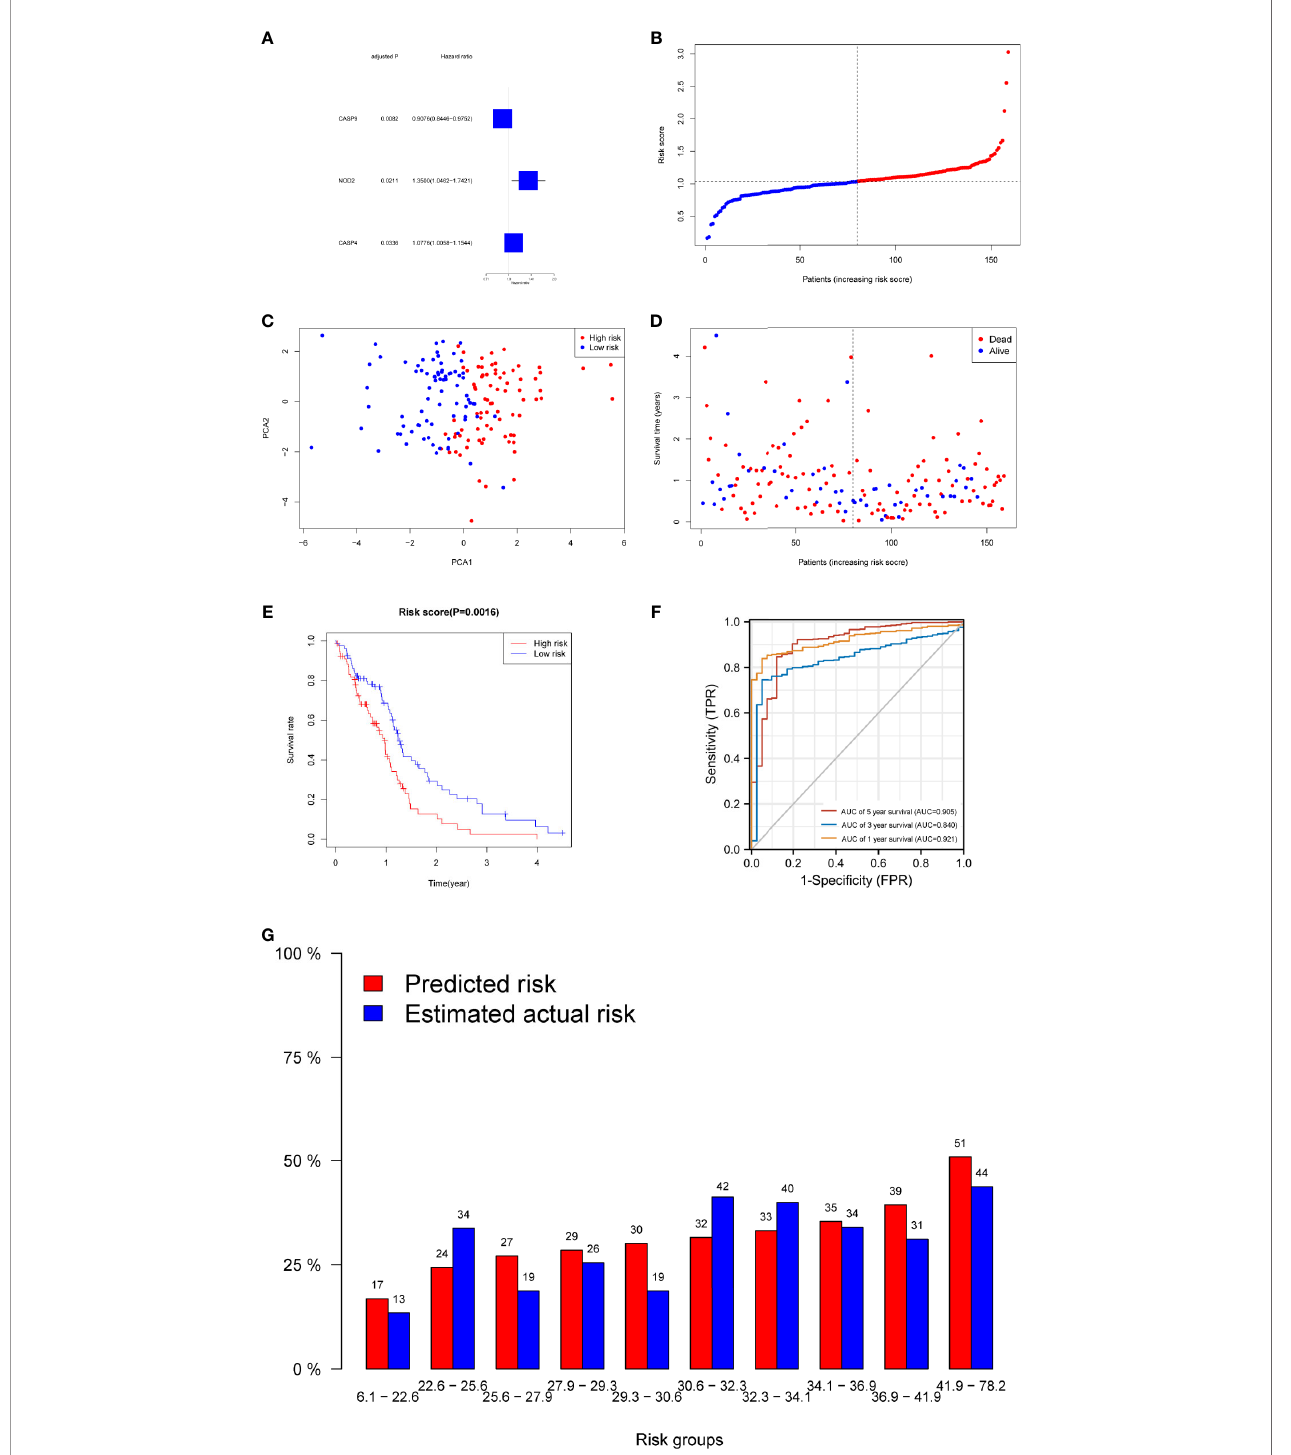
FIGURE 2 | Prognostic analysis of the three-gene signature model in the derivation cohort. (A) Forest plots showing the results of the univariate Cox regression analysis between gene expression and OS. (B) The distribution and median value of the risk scores in the derivation cohort. (C) PCA plot of the derivation cohort. (D) The distributions of OS status, OS, and risk score in the derivation cohort. (E) Kaplan – Meier curves for the OS of patients in the high-risk group and low-risk group in the derivation cohort. (F) AUC of time-dependent ROC curves veri fi ed the prognostic performance of the risk score in the derivation cohort. (G) Calibration plot for predicted versus estimated actual